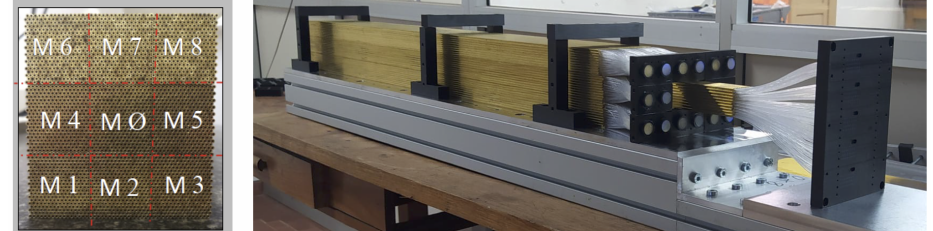
Figure 1. A front view ( left ) and a side view ( right ) of the em-size prototype before the connection to the light sensors (PMTs and SiPMs) are shown in picture. The fibres from the external modules (M1–M8) are bundled to match the PMTs’ window while the longer fibres from the central module (MØ) are connected to a patch panel to be interfaced with